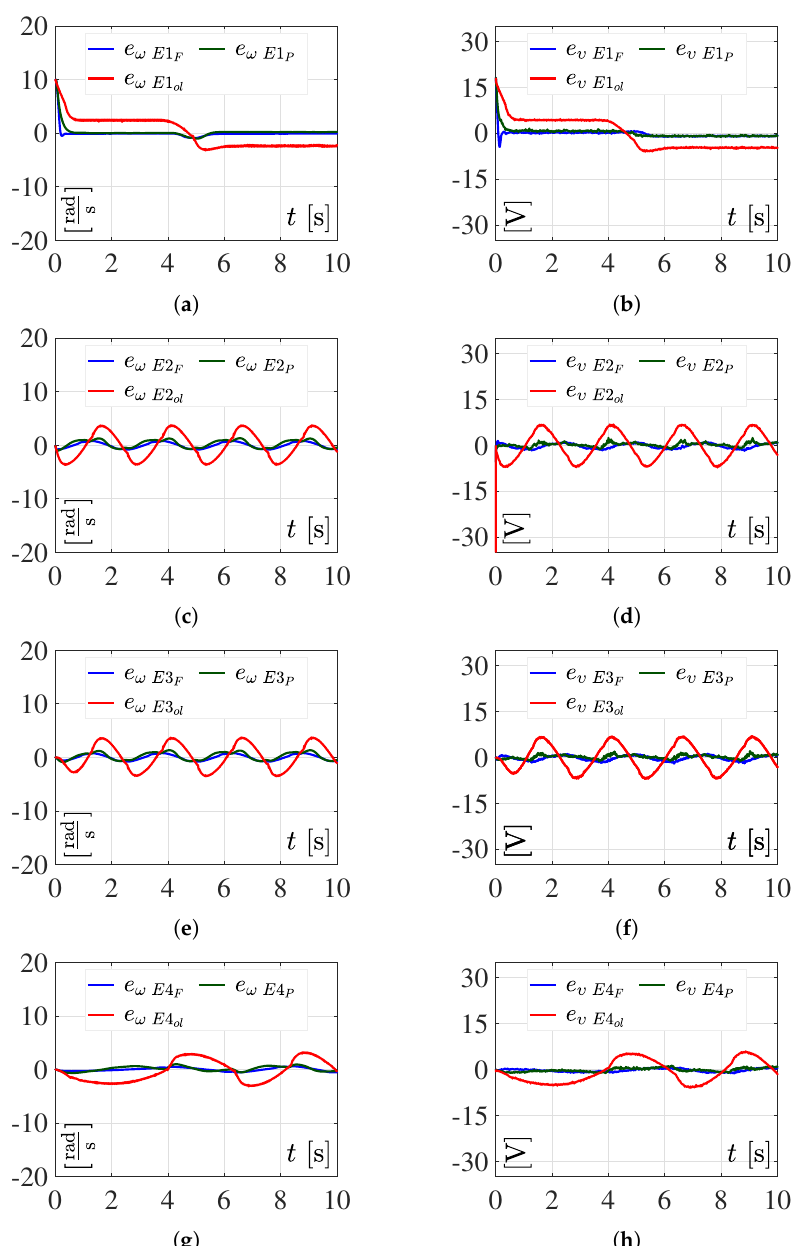
Figure 15. Plotted graphics of the tracking errors associated with variables ω and υ of the full-bridge Buck inverter–DC motor system. The signal pairs e ω E { 1,2,3,4 } – e υ E { 1,2,3,4 } , e ω E { 1,2,3,4 } – e υ E { 1,2,3,4 } , F F P P and e ω E { 1,2,3,4 } – e υ E { 1,2,3,4 } are the tracking errors obtained for ω and υ , when the system con- ol ol siders the flatness-based control, the passivity-based control [41], and the experimental results in open-loop [40], respectively. ( a ) Tracking errors of ω , for the desired trajectory ω ∗ declared in (22). ( b ) Tracking errors of υ , for the desired trajectory ω ∗ declared in (22). ( c ) Tracking errors of ω , when the desired profile ω ∗ is given by (23). ( d ) Tracking errors of υ , when the desired profile ω ∗ is given by (23). ( e ) Tracking errors of ω , for ω ∗ defined by (24). ( f ) Tracking errors of υ , for ω ∗ defined by (24). ( g ) Tracking errors of ω , for the desired trajectory considered in (25). ( h ) Tracking errors of υ , for the desired trajectory considered in